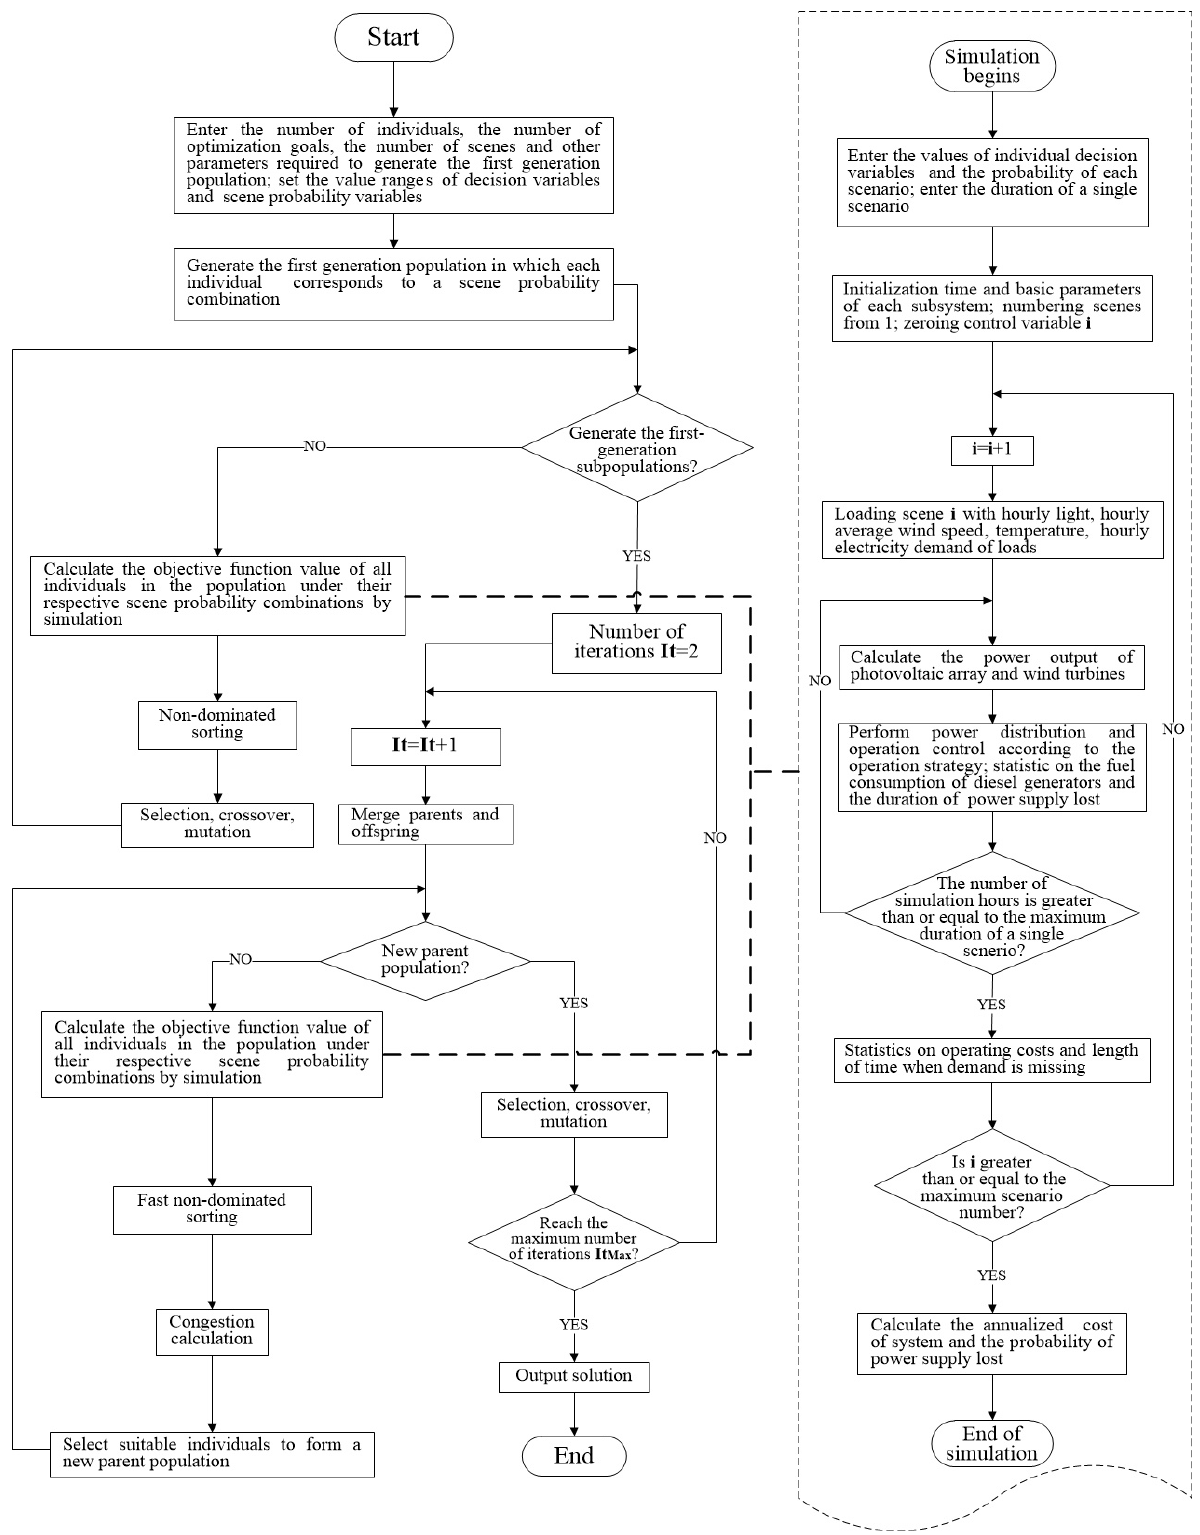
Figure 4. Flowchart of the PUSS model based on NSGA-II. The input variables include the population size, the number of objectives, the total number of scenarios, the range of the decision variables, and the probability variables of the scenarios. Then, we generate the initial population and start the evolutionary computation. The objective function value is calculated by the simulation of the